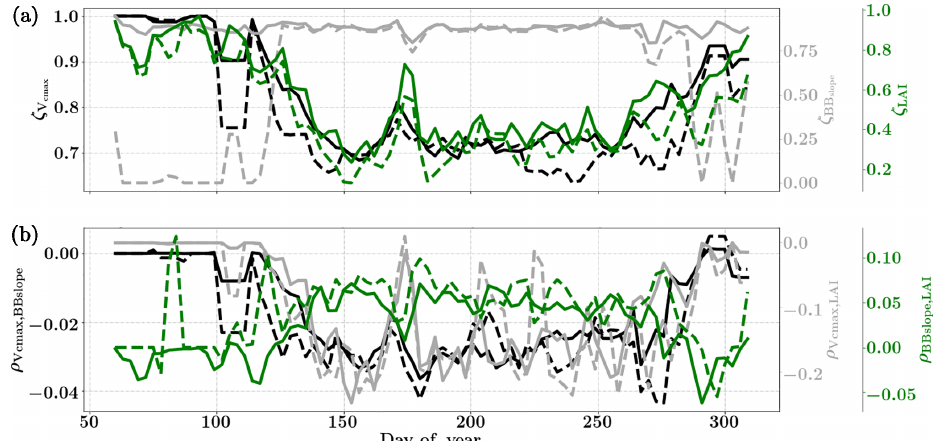
Figure 11. Figure showing the seasonal variability of the posterior error reduction ( ζ ) and correlation coefficient of the retrieved param- eter values of V cmax , BB slope and LAI for the Missouri Ozark site using a 3-day moving window inversion approach for the year 2009. Panel (a) shows the ζ V , ζ BB and ζ LAI for the entire growing season and (b) shows the correlation coefficients (normalized off- slope cmax diagonal elements of posterior error covariance matrix) among these variables. The results of retrievals using only GPP and LE fluxes are shown as dashed lines and the results using a combination of fluxes and MODIS reflectance are shown as solid lines. Both the ζ and correlation coefficients are computed using the final Jacobian matrix at the end of each retrieval window.